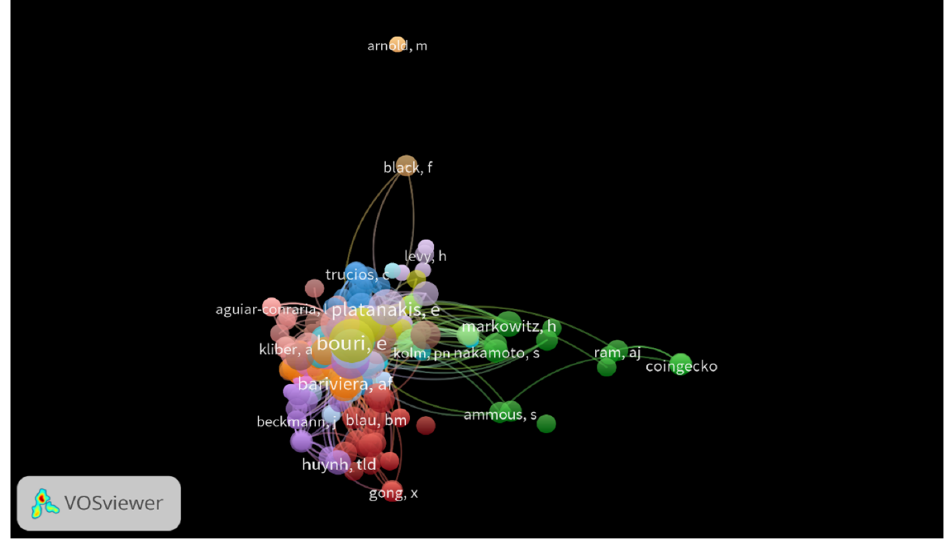
Figure 2. Co-citation analysis (units of analysis are cited authors). There are 16 clusters detected according to co-citation analysis, the total number of cited authors is 661. Carpenter (2016) confirms that Bitcoin has low correlations associated with extremely high yields and volatility. It means that Bitcoin can serve as a tool for portfolio diversifi- cation according to a modified mean-variance framework. The results show that Bitcoin portfolios tended to outperform other portfolios in the analyzed period. If the portfolio includes BTC, then the Sharpe ratio increases significantly from 0.98 to 1.57, similar to the Sartion ratio from 1.42 to 2.17. In this case, there is a significant increase in return per unit of risk. Specifically, if the portfolio contains 14% Bitcoin, then the return will increase from the original 13% to 26%. On the other hand, the risk will increase slightly from the original 13% to 17%. In other words, Bitcoin is an attractive investment that increases the return- to-risk ratio of an efficient portfolio. These positive results are especially for the specula- tive bubble from 2013 to 2014. If the sample does not contain data before February 2014 (end of the bubble), then the portfolio with Bitcoin does not perform better than other portfolios. Subsequently, Briere et al. (2015) use weekly data from 2010 to 2013 to analyze Bitcoin from the perspective of an American investor. This portfolio consists of traditional assets, namely, global stocks, bonds, and currencies, but also commodities, hedge funds, and real estate. Bitcoin was characterized by its high yields and volatility in the analyzed period. Briere et al. (2015) use the weekly BTC/USD exchange rates from Bitcoincharts for the period from 23 July 2010 to 27 December 2013. The results show that the correlation between Bitcoin and other assets was low. Only two assets show a significant correlation with Bitcoin, namely, gold and inflation-linked bonds. In addition, high risk is associated with low correlations with other assets. Bitcoin can improve the returns and risk of the entire portfolio. Briere et al. (2015) demonstrate that Bitcoin offers significant benefits for portfolio diversification. If the portfolio contains only a small proportion of Bitcoin, then the trade-off between return and risk of the diversified portfolio dramatically improves. Briere et al. (2015) point out that the results may not reflect behavior in the medium or long term. Many studies focus on the benefits of adding an alternative asset to a traditional port- folio. On the other hand, Liu (2019) optimizes a portfolio composed exclusively of virtual currencies using six classical models. Liu (2019) draws data on cryptocurrencies from 7 August 2015 to 9 August 2019, a total of 977 business days. Liu (2019) uses cryptocurren- cies with a market capitalization of more than a billion, namely, Bitcoin, Ethereum, Ripple, Litecoin, Stellar, Monero, Dash, Tether, NEM, and Verge. Liu (2019) examines the perfor-